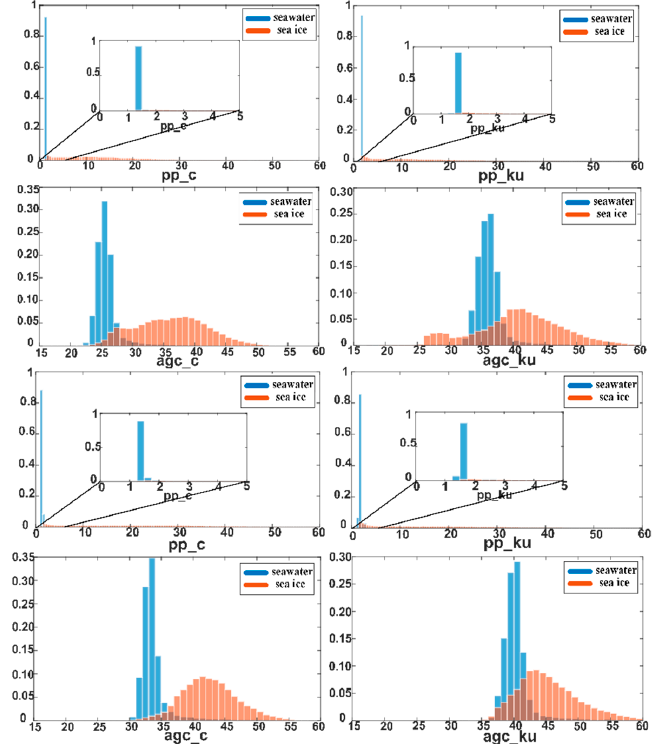
Figure 8. Histogram of the sea ice and seawater from the HY-2A/B. Note: A – D are the results of the HY-2A; E – H are the results of the HY-2B. HY-2A; E – H are the results of the